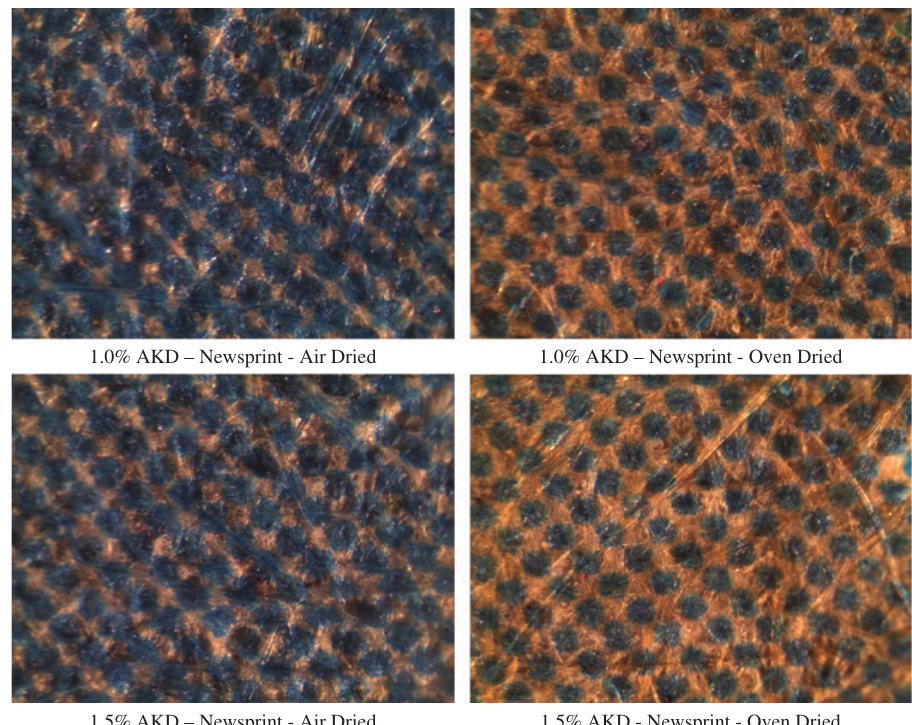
Figure 6: Magnified ( × 50) images of screen dots (80%) on the offset printed of